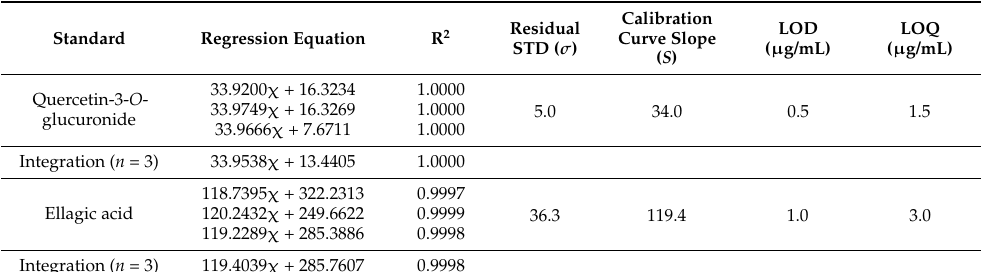
Table 1. Results of linearity regression, correlation coefficient, LOD, and LOQ for quercetin-3- O - glucuronide and ellagic acid.